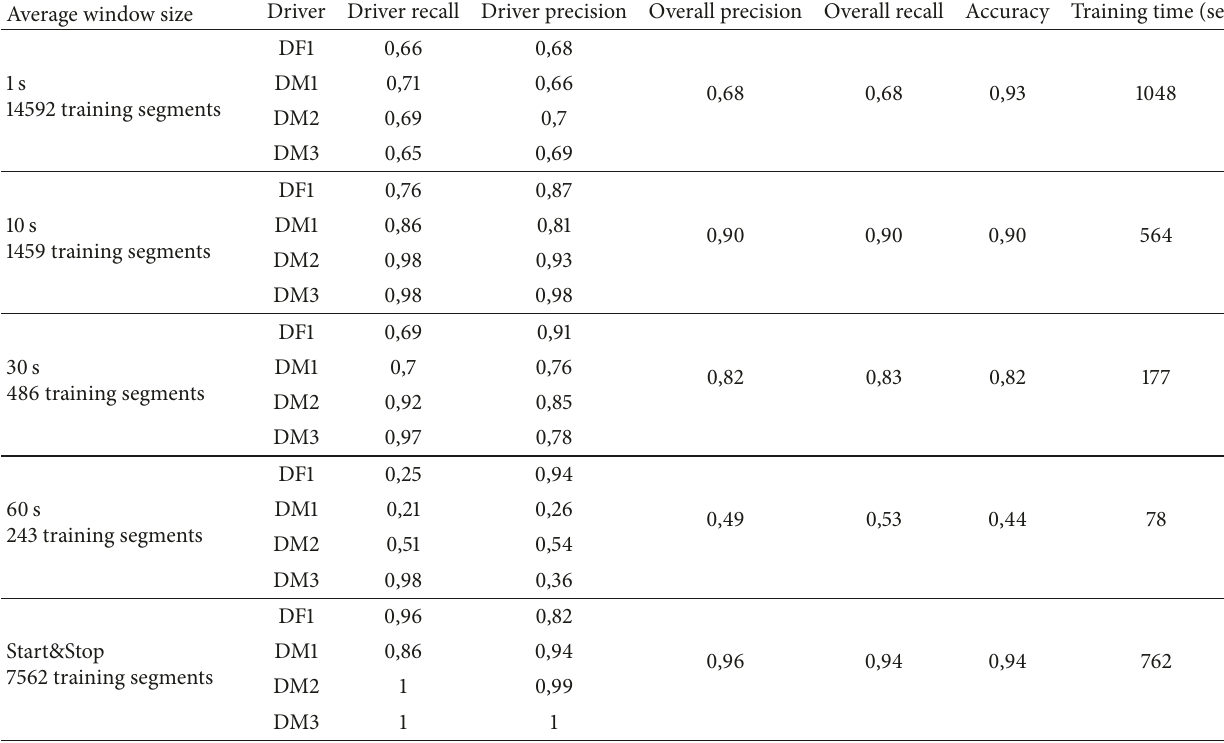
Table 3: 𝐸 11 , precision, recall, accuracy, and training time obtained by using the MLP classifier for different windows sizes. Average window